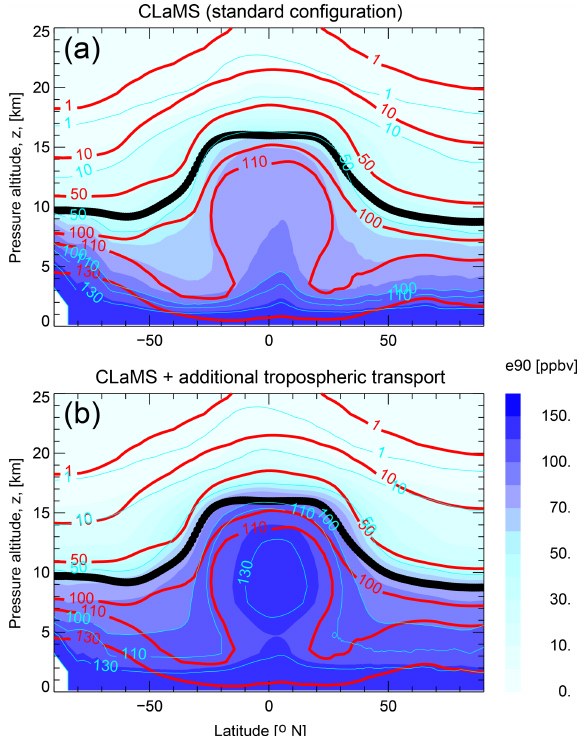
Figure 1. The different shades of blue quantify the annual mean of the e90 tracer mixing ratios (calculated for 2007) as a function of latitude and log-pressure altitude and are derived from the current version of CLaMS v1.0 described in Pommrich et al. (2014) (a) and from the version discussed here with extended tropospheric trans- port (b) . For comparison, the WACCM 1955–2099 climatology of e90 is also shown (red isolines) as described in Abalos et al. (2017). The mean tropopause is depicted by the black